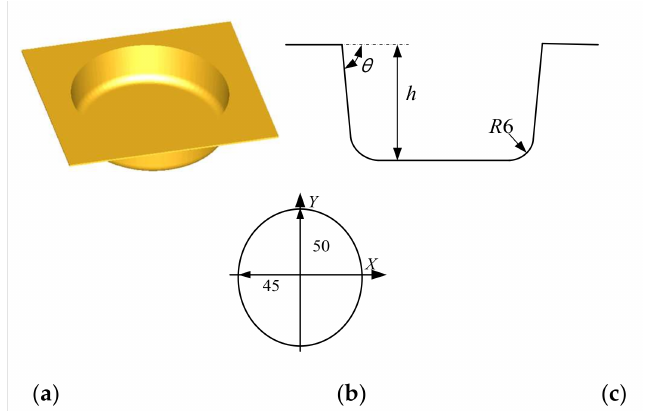
Figure 12. The straight-wall part model: ( a ) three-dimensional model; ( b ) longitudinal section; ( c ) cross